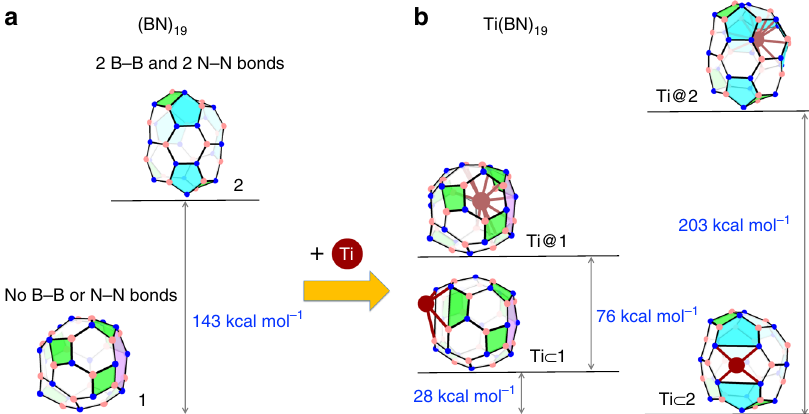
Fig. 1 Relative energies of two isomers of pristine cages (BN) 19 and of their Ti-doped complexes. a Isomer 1 is the lowest energy form of (BN) 19 , consisting of 7 squares, 13 hexagons, and 1 octagon, with no B – B or N – N bond present. Isomer 2 contains 3 squares, 6 pentagons, and 12 hexagons. The presence of two B – B and two N – N bonds makes the latter isomer lie signi fi cantly higher in energy than the former. b Conversely, when doped with a single Ti atom, cage 2 becomes much more stable than cage 1 , and gives the global minimum structure of Ti(BN) 19 . For both cages, the exohedral complex, Ti (cid:1) (BN) 19 , has substantially lower energy than the corresponding endohedral one, Ti@(BN) 19 . All relative energies (including zero-point energy correction) have been obtained from DFT calculations. Boron, nitrogen, and titanium atoms are indicated by pink, blue, and dark red circles, respectively. Squares, pentagons, hexagons, and octagons are shown in green, cyan, white, and magenta,